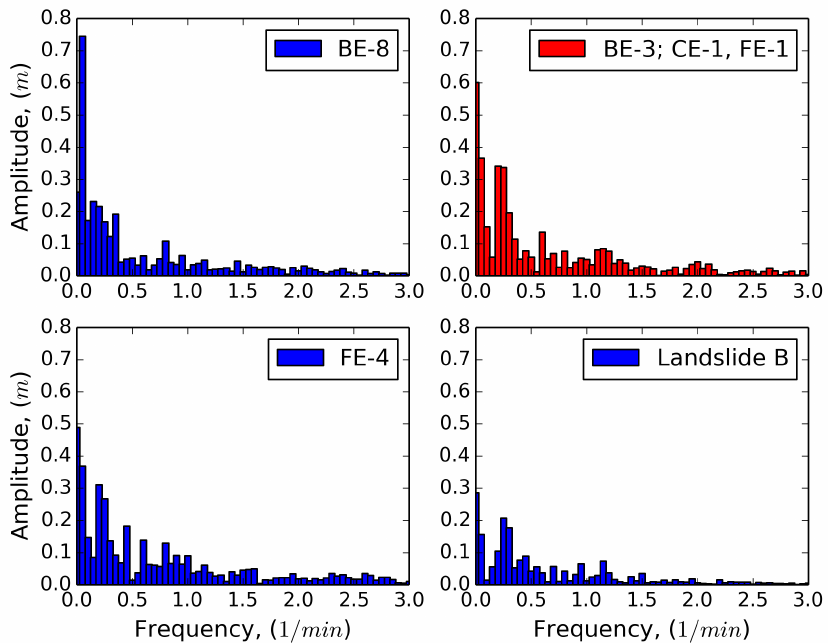
Figure 10. Frequency (1/min.) domain signal of the wave height from model simulations in the Pantoloan tide gauge (Station 19, Figure 2 left panel). Upper left : BE-8; upper right : BE-3; bottom left : FE-4; bottom right : individual landslide B